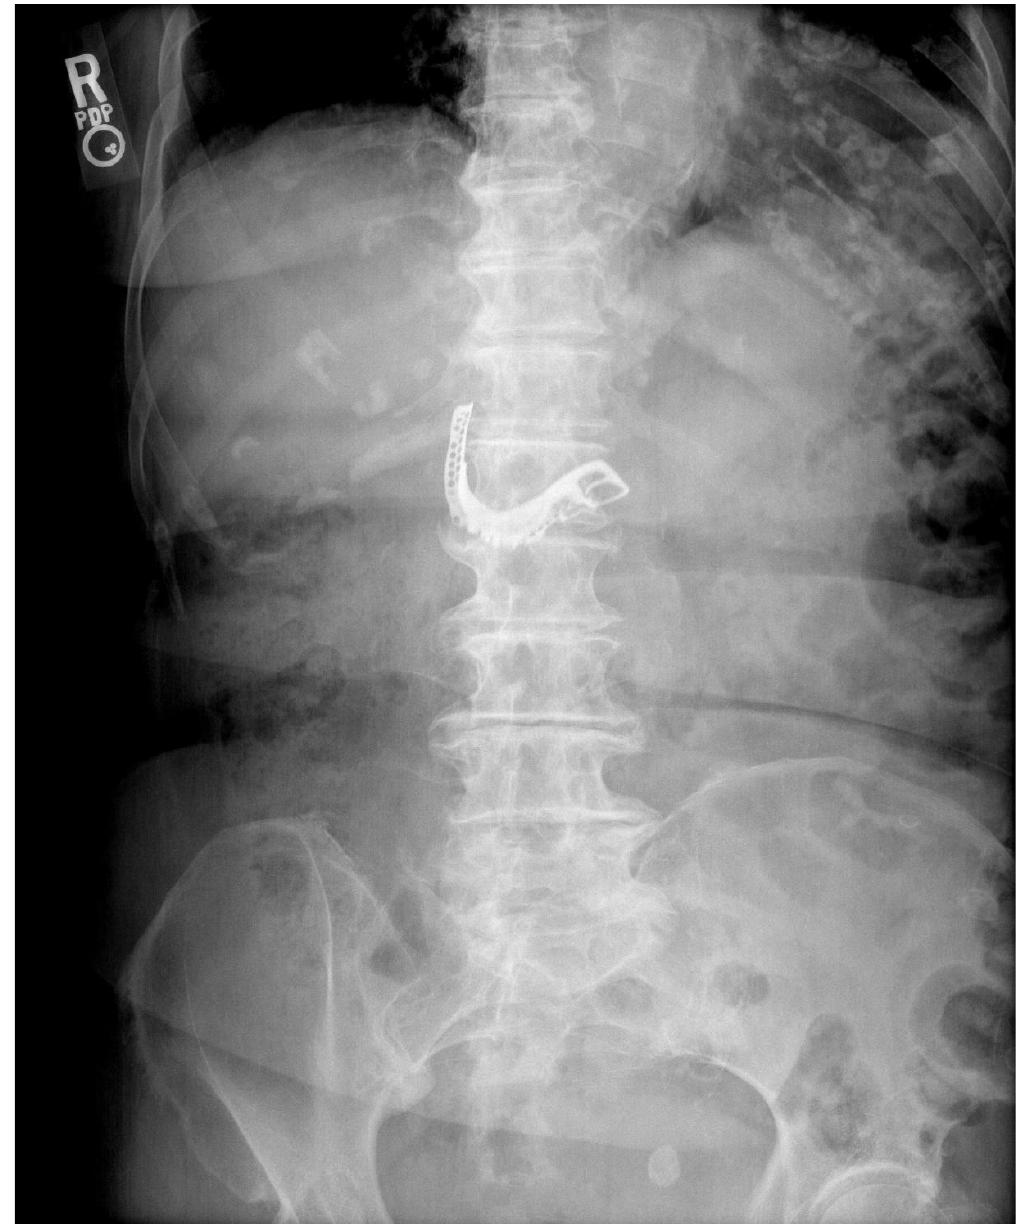
Figure 1. Abdominal XR.